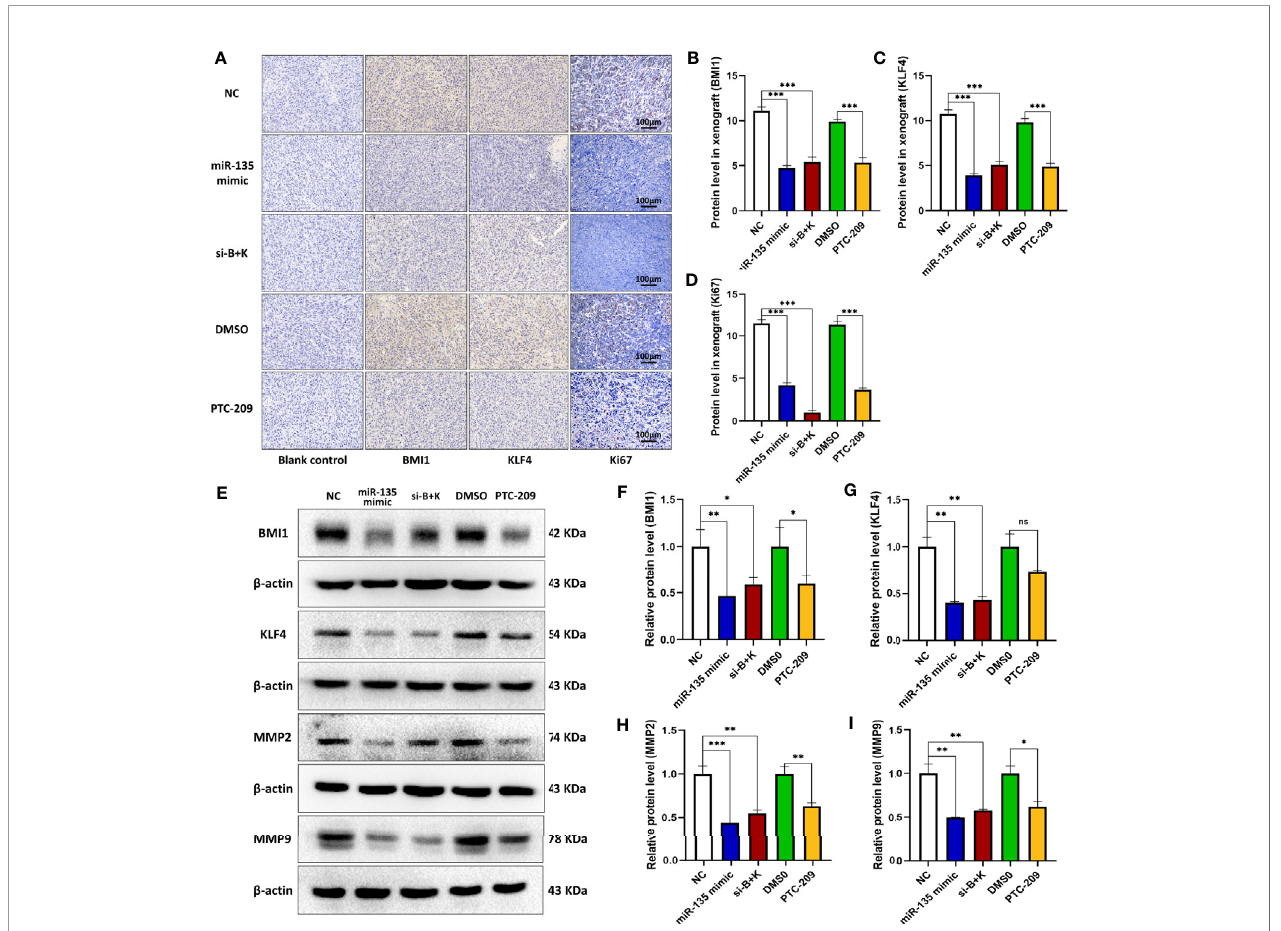
FIGURE 5 | miR-135a, combination therapy, and PTC-209 suppression of BMI1 and KLF4 in mouse OS cell xenografts. (A) Immunohistochemistry. The mouse OS cell xenografts were resected from the nude mice and subjected to tissue processing, embedding, sectioning, and immunohistochemistry. Scale bar, 100 m m. (B – D) The graph of the quanti fi ed data of immunohistochemical staining of BMI1, KLF4, and Ki67. (*** p < 0.001; n = 10). (E) Western blot. The mouse OS cell xenografts were resected from the nude mice and subjected to protein extraction and western blot. (E – I) The graph of the quanti fi ed data of the western blots (ns p >0.05; * p <0.05; ** p < 0.01; *** p < 0.001; n = 3). The data were expressed as the mean ± SEM. ns, not signi fi